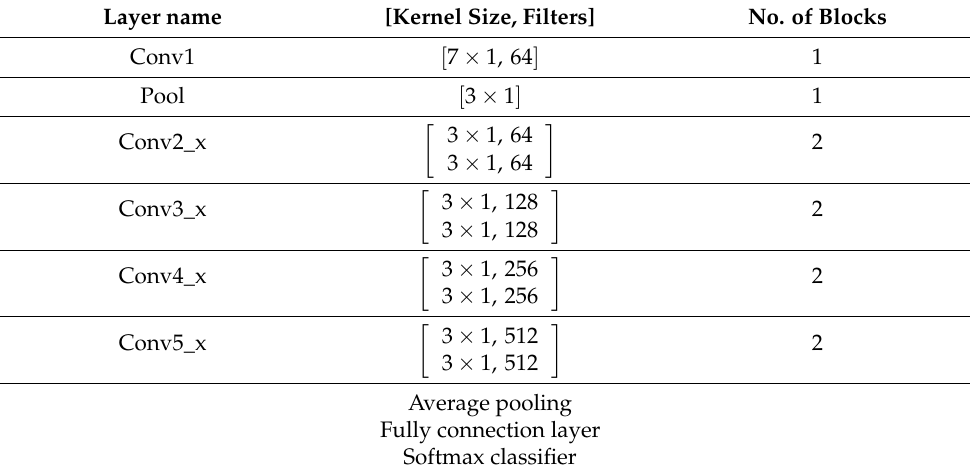
Figure 3. A residual block in ResNet. Table 1. Architecture of ResNet-18.